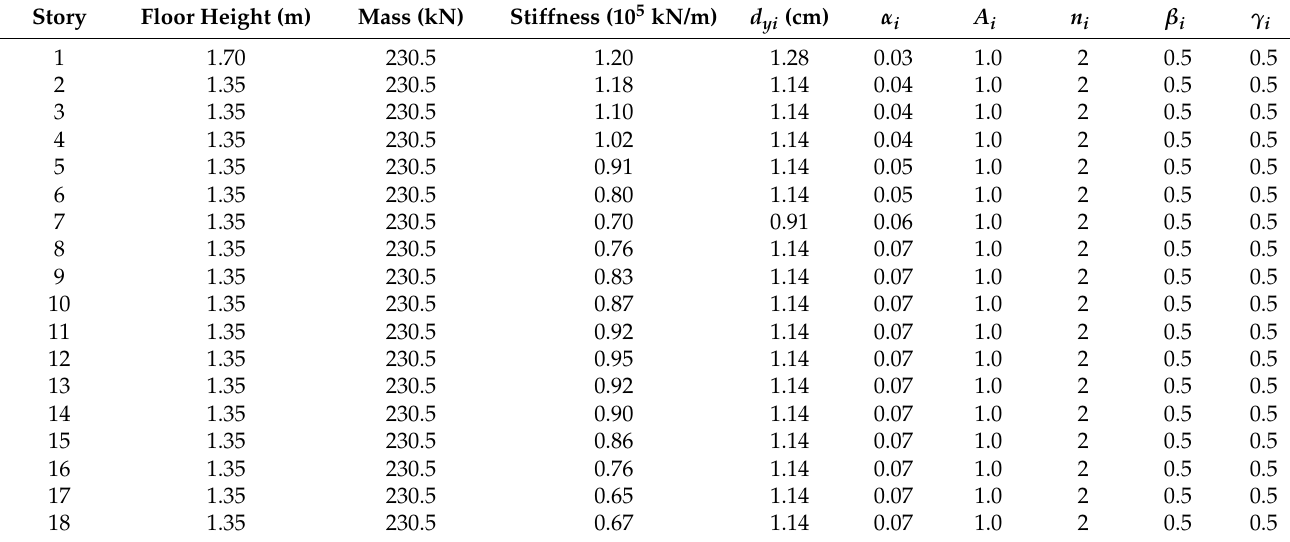
Table 4. Parameters of Bouc-Wen hysteresis curve for the 18-DOF shear-building model.